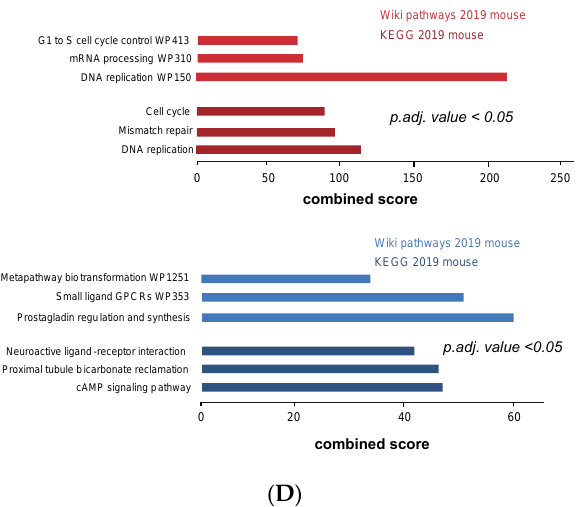
Figure 4. The KEOPS complex as putative key regulator of tumor maintenance in murine TH-MYCN driven neuroblastoma. ( A ) (top) Heatmaps displaying the top-100 up- (left, p < 0.01 and log 2 fold change > 1) and downregulated genes (right, p < 0.01 and log 2 fold change < −1) in TH-MYCN +/+ versus wild type samples common at 2 and 6 weeks of age versus week 1. (bottom) Boxplots ( p -value corresponds to the interaction term of a two-way ANOVA analysis) represent the scoring of these gene lists as signatures in a large cohort of primary human neuroblastomas (GSE120572). ( B ) (left) Gene ontology analysis using Enrichr (maayanlab.cloud/Enrichr [24]) based on the “Wiki pathway mouse” and “KEGG mouse” databases for pathway enrichment analysis for up- ( red ) and downregulated ( blue ) genes in TH-MYCN +/+ versus wild-type samples overlapping between 2 and 6 weeks versus week 1; (right) network representation by means of the cytoscape plugin “Enrichment Map” of the Gene set enrichment analysis results using the C5_BP MSigDB collection for upregulated ( red ) genes in TH-MYCN +/+ versus wild-type samples overlapping between 2 and 6 weeks after birth. An FDR-q cut-off of 0.1 was used for network visualization. ( C ) (top) Heatmap displaying the top-100 up- (left, p < 0.01 and log 2 fold change > 1) and downregulated genes (right, p < 0.01 and log 2 fold change < − 1) in TH-MYCN +/+ versus wild-type samples uniquely at 6 weeks of age versus week 1. (bottom) Boxplots ( p -value corresponds to the interaction term of a two-way ANOVA analysis) represent the scoring of these gene lists as signatures in a large cohort of primary human neuroblastomas (GSE120572). ( D ) Gene ontology analysis using Enrichr (maayanlab.cloud/Enrichr [24]) based on the “Wiki pathway mouse” and “KEGG mouse” databases for pathway enrichment analysis for upregulated ( red ) genes in TH-MYCN +/+ versus wild type samples at uniquely 6 weeks of age versus week